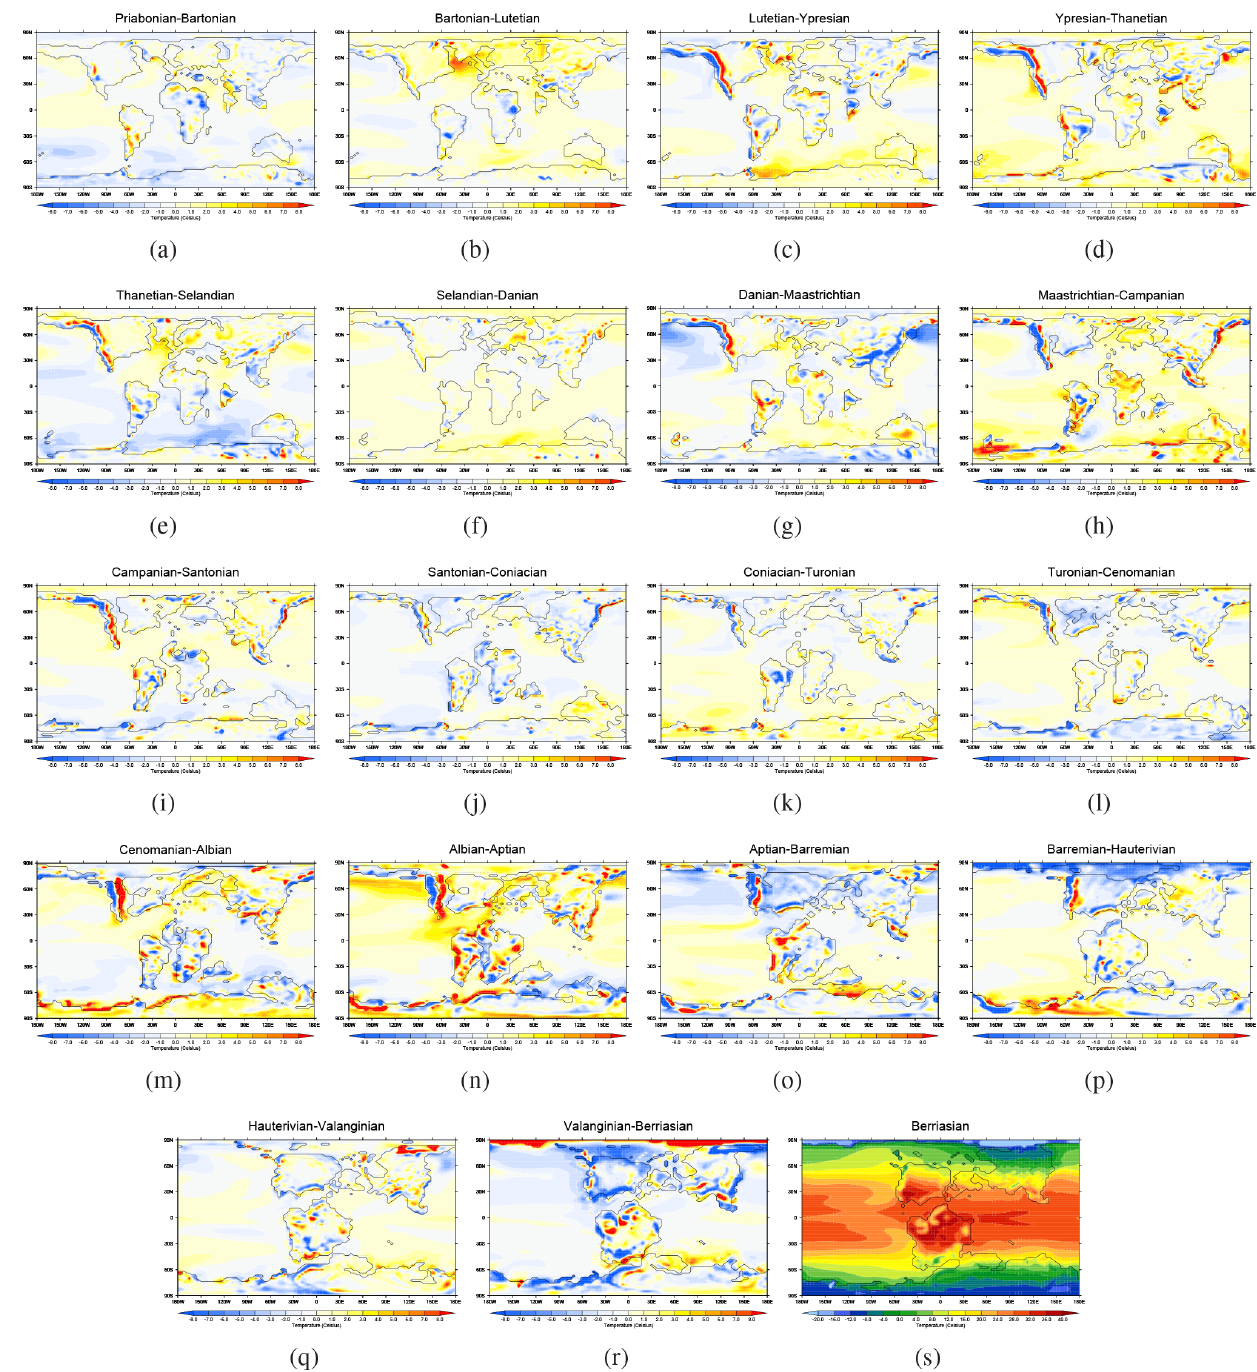
Figure 6. (a–r) Annual mean surface air temperature (at 1.5m) for each geological Stage, expressed as an anomaly relative to the pre- vious Stage. (a) Priabonian–Bartonian, (b) Bartonian–Lutetian, (c) Lutetian–Ypresian, (d) Ypresian–Thanetian (e) Thanetian–Selandian, (f) Selandian–Danian, (g) Danian–Maastrichtian, (h) Maastrichtian–Campanian, (i) Campanian–Santonian, (j) Santonian–Coniacian, (k) Coniacian–Turonian, (l) Turonian–Cenomanian, (m) Cenomanian–Albian, (n) Albian–Aptian, (o) Aptian–Barremian, (p) Barremian– Hauterivian, (q) Hauterivian–Valanginian, (r) Valanginian–Berriasian. (s) Annual mean surface air temperature (at 1.5m) for the Berriasian